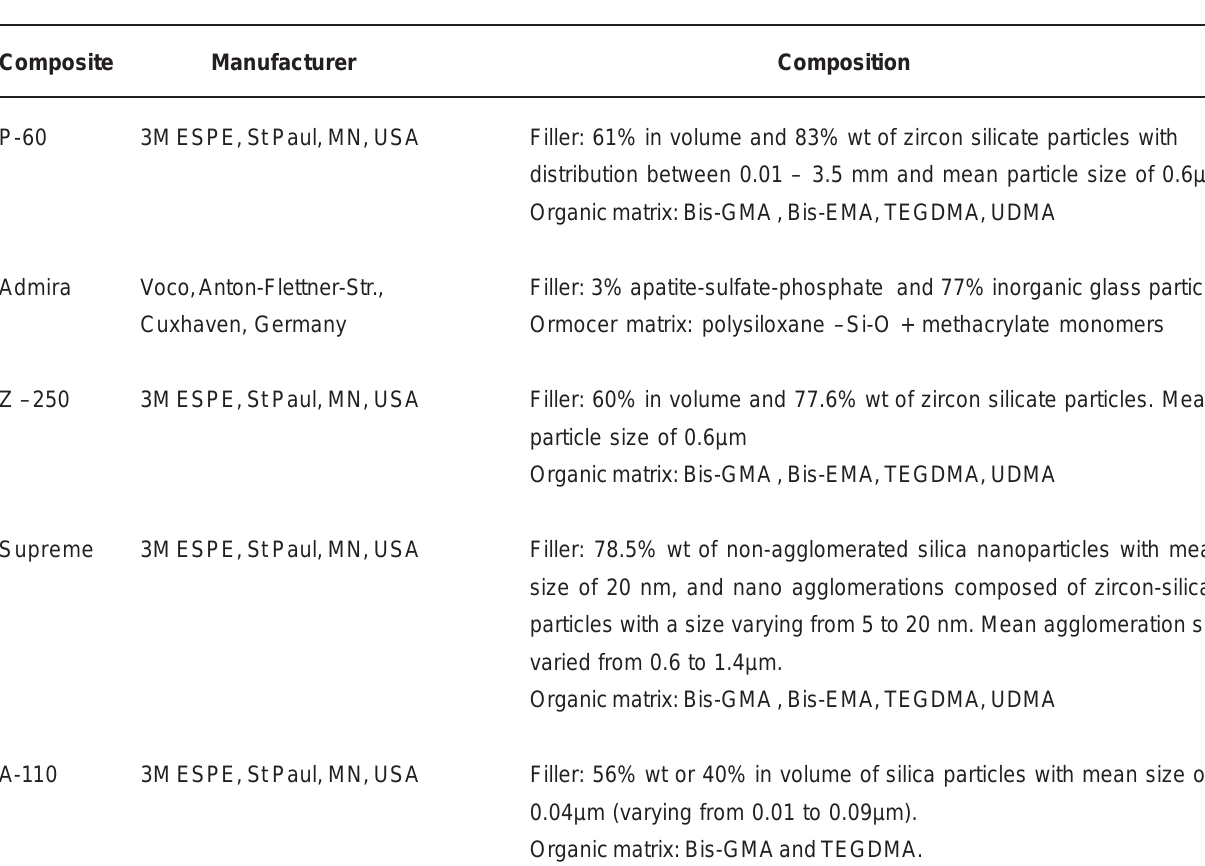
TABLE 1- Composition of dental composites used in the